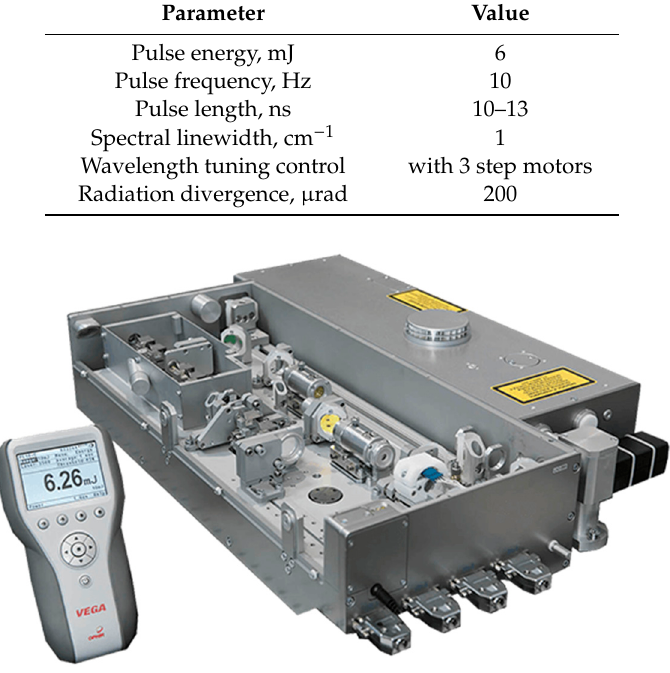
Figure 2. Laser system [28].